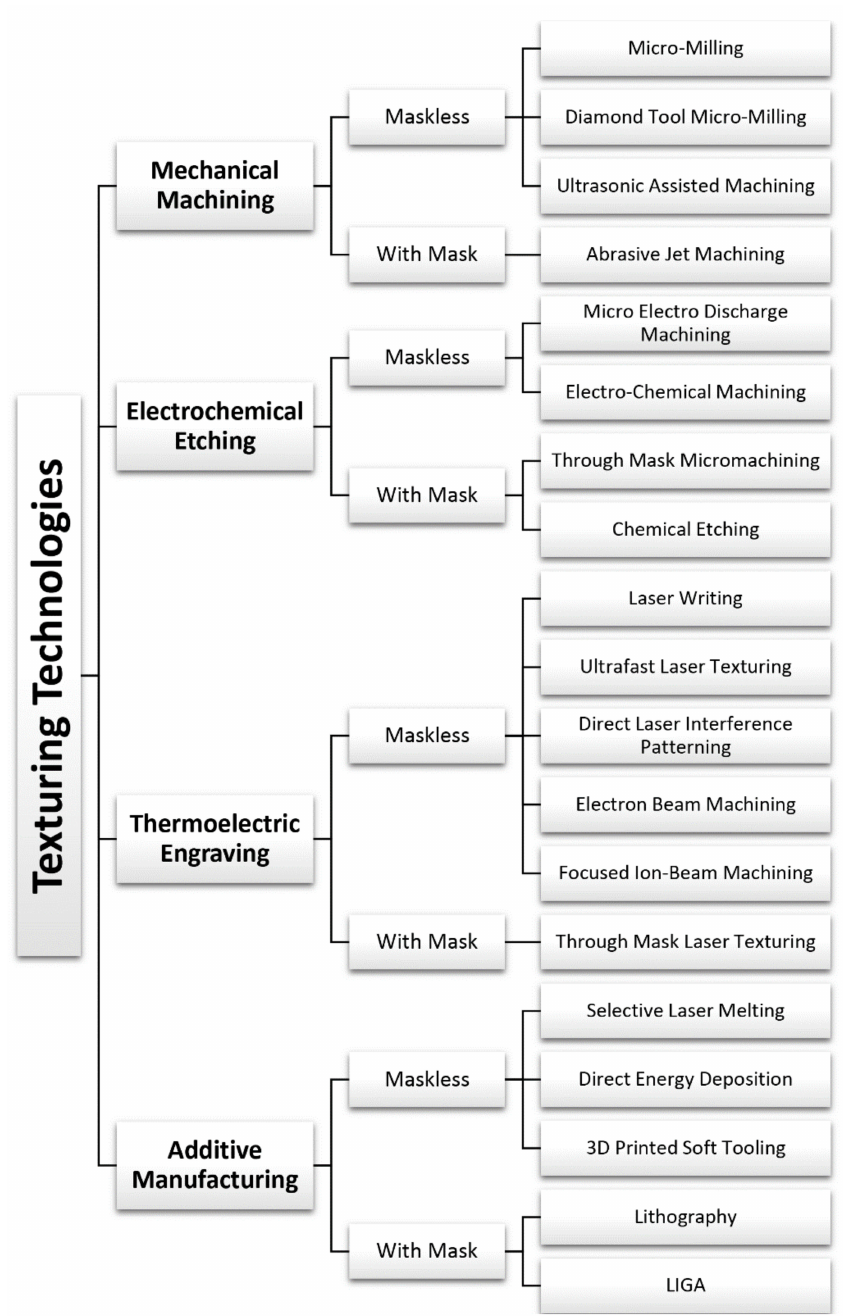
Figure 1. Summary and classification of texturing